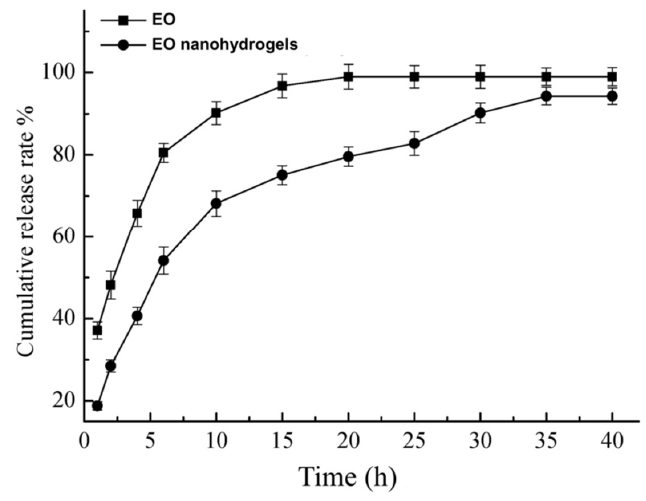
Figure 6. In vitro release of QEO nanohydrogels and free QEO.